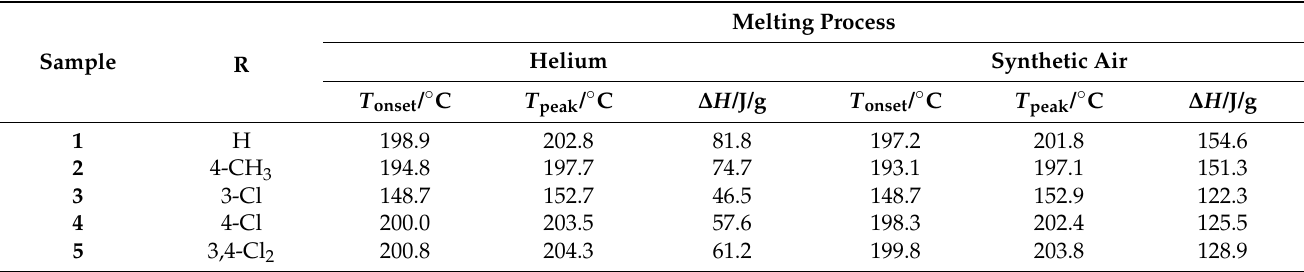
Figure 2. The DSC curves for compounds 1 – 5 (a helium atmosphere). Figure 2 . The DSC curves for compounds 1 – 5 (a helium atmosphere). Table 1. The DSC data for compounds 1 – 5 (helium and synthetic air Table 1 . The DSC data for compounds 1 – 5 (helium and synthetic air atmospheres).